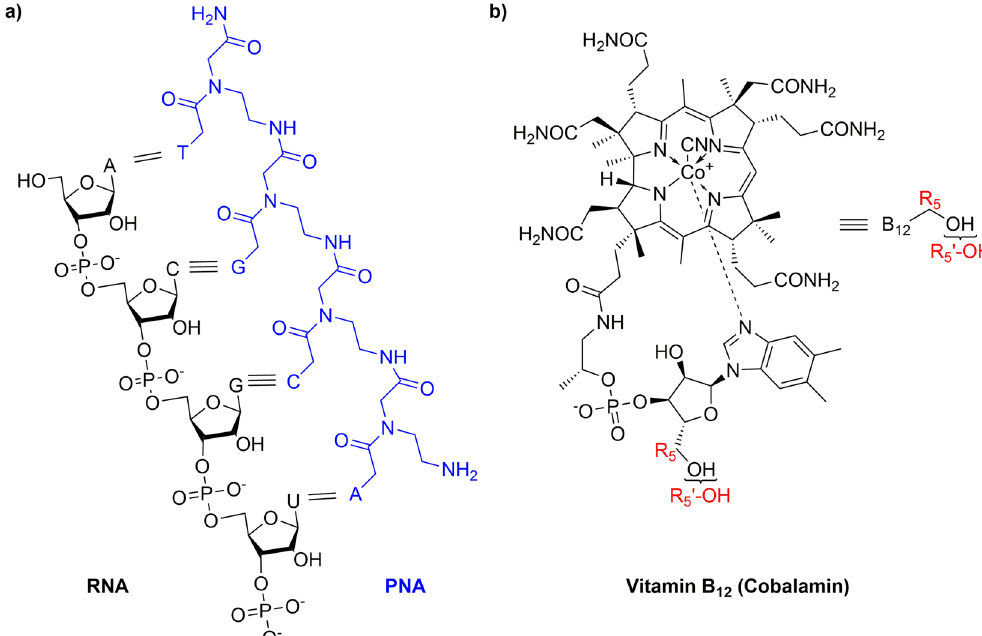
Figure 1. ( a ) Chemical structure of a PNA oligomer and its complementary pairing scheme with natural RNA. ( b ) Vitamin B 12 in the form of cyanocobalamin used in this study. R 5 refers to the fifth carbon of the ribose moiety, while R 5 ′ -OH stands for the primary hydroxyl group according to the nomenclature of cobalamin 4